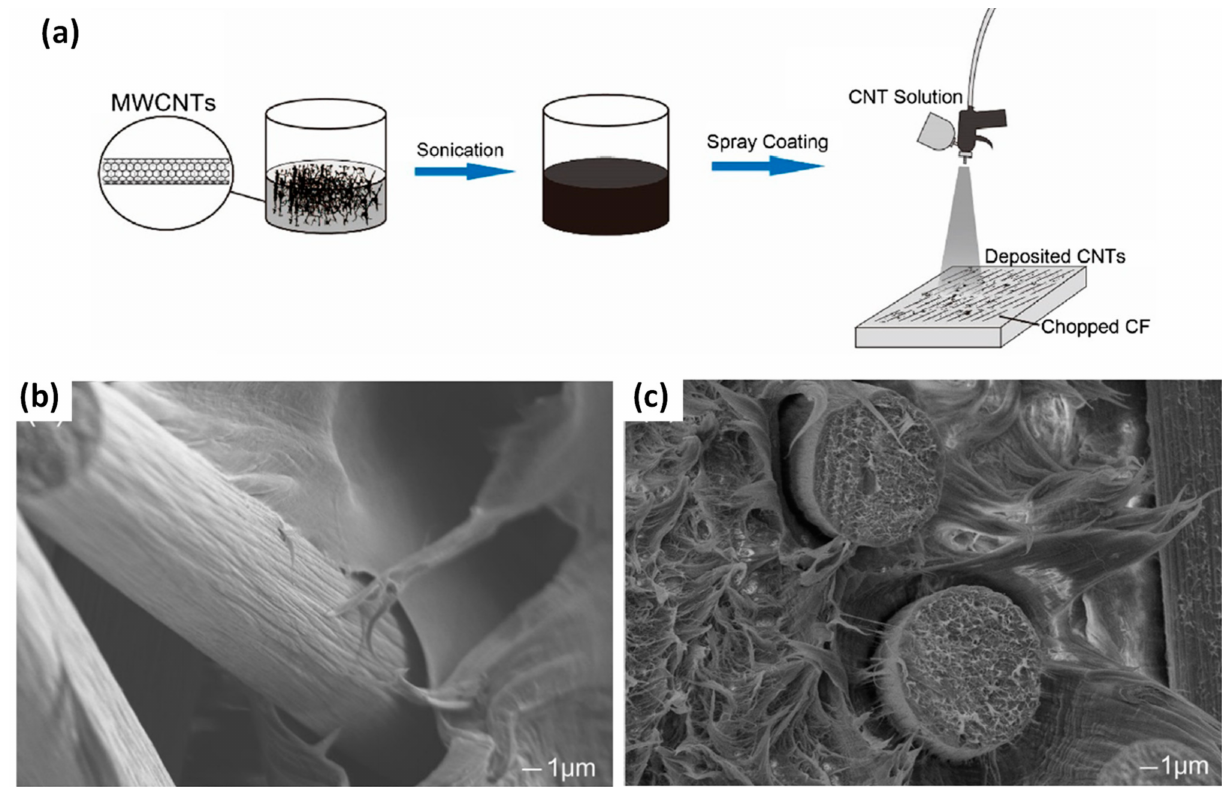
Figure 6. ( a ) schematic for the spraying coating of CNT onto carbon fibres, Fracture surfaces for ( b ) pristine carbon fibre/HDPE composites and ( c ) CNTs coated carbon fibre/HDPE composites (reprinted with permission from Hu et al., 2019